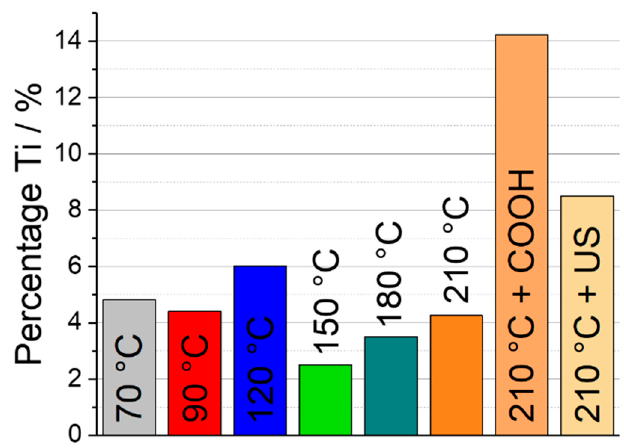
Figure 3. Titanium content in percentage on the PES membrane with TiO 2 nanoparticles synthesized at different temperatures (70 °C, 90 °C, 120 °C, 150 °C, 180 °C, and 210 °C) and modified with carboxyl groups prior to the dip-coating (210 °C + COOH) and modified with ultrasound (210 °C + US). The titanium content was determined by XPS.